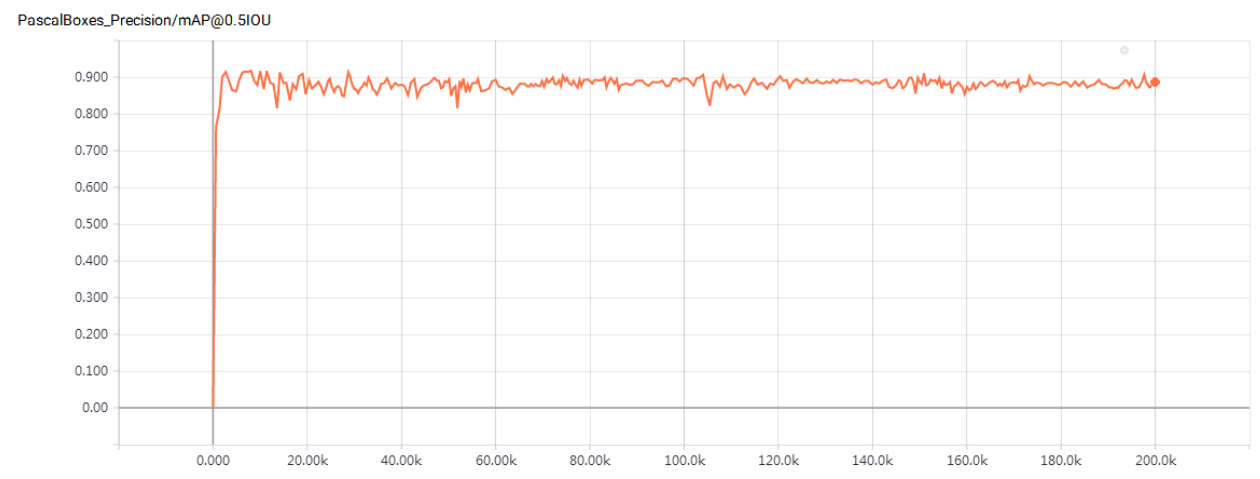
Figure 17. MAP value of faster R-CNN (101-layer ResNet) model.